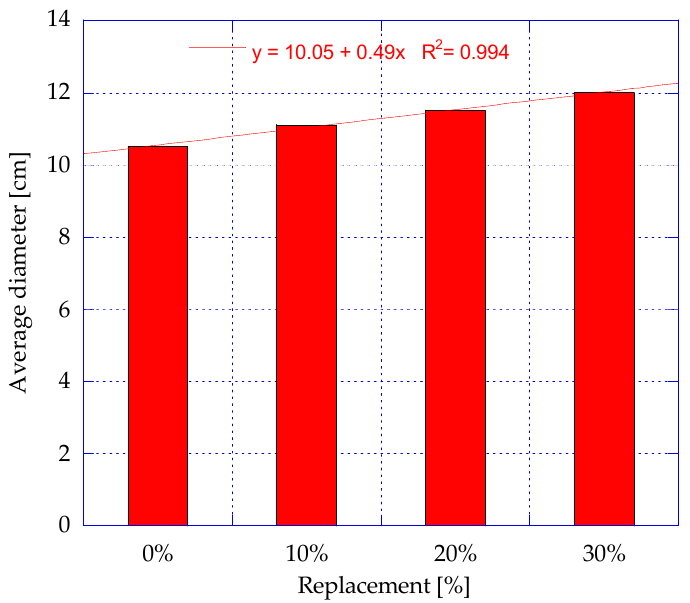
Figure 7. Mortar consistency with different cupola slag replacements.